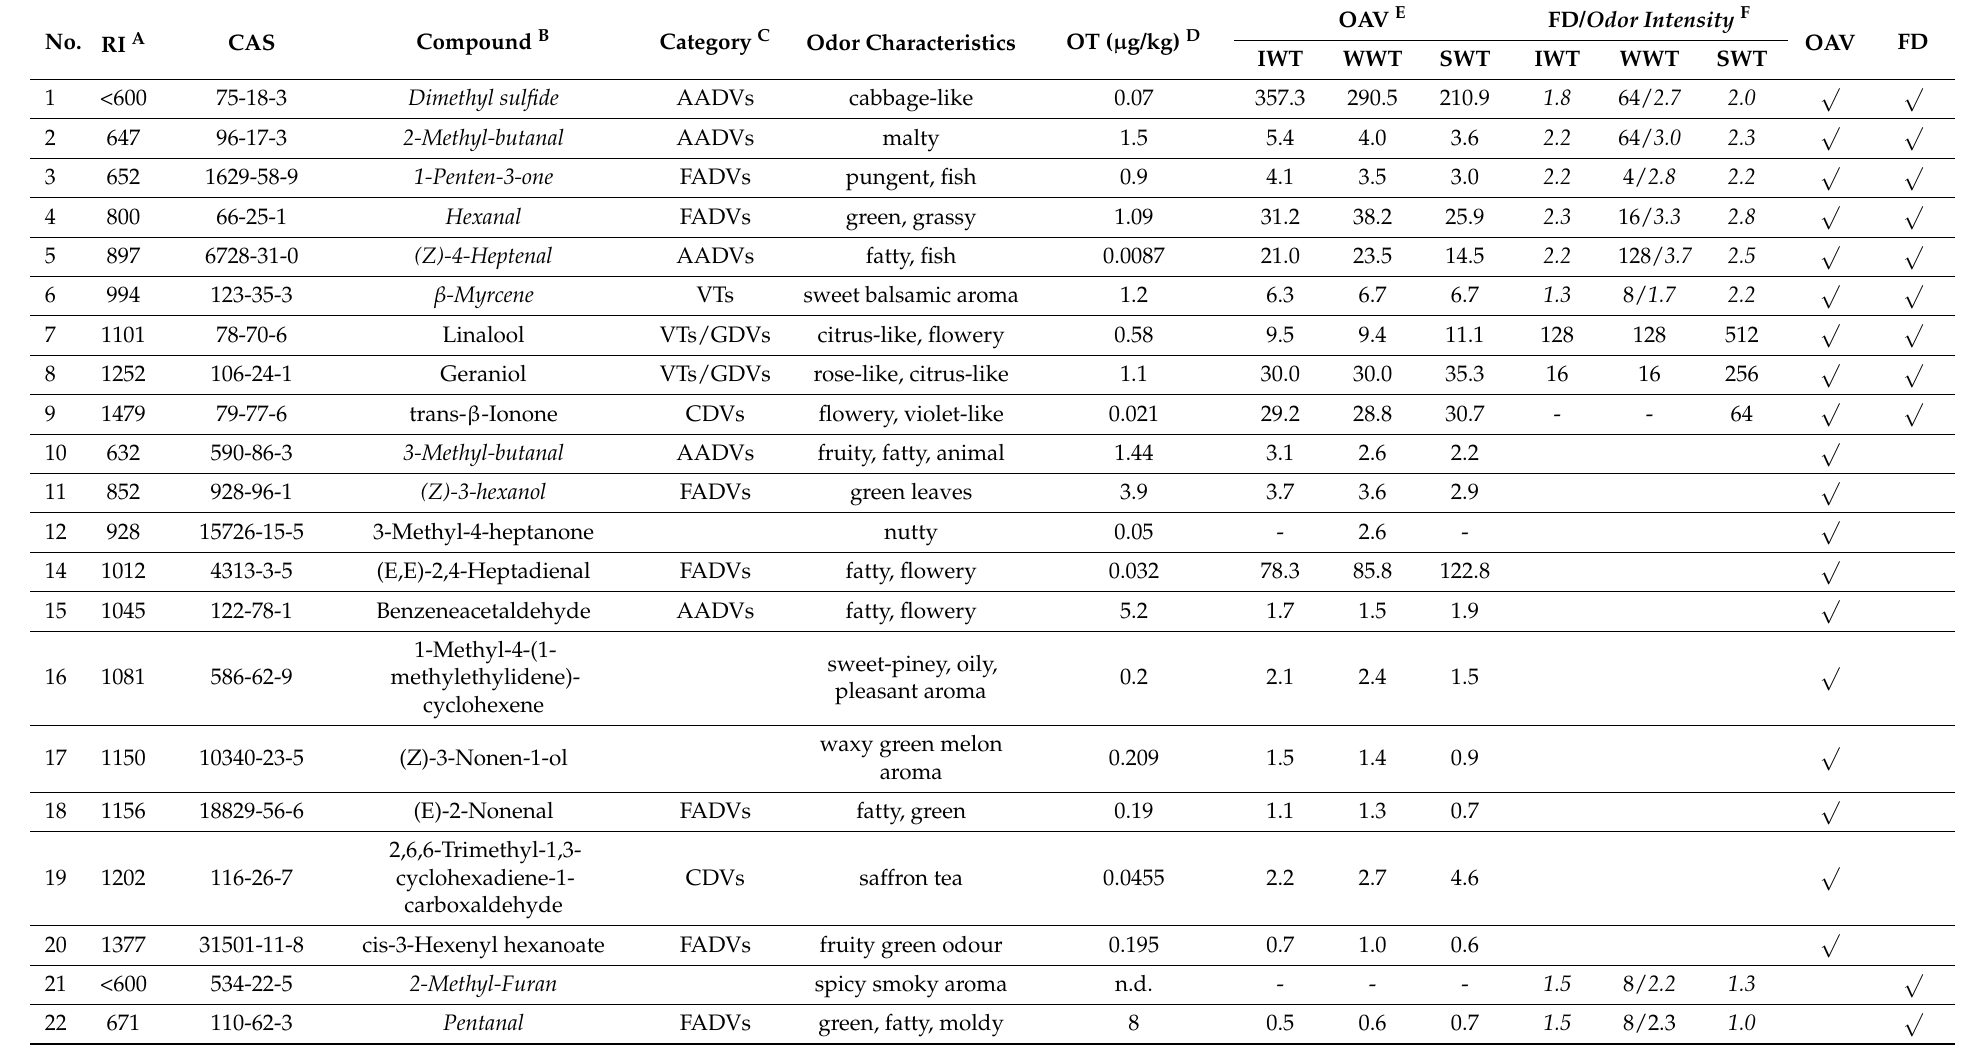
Table 1. Flavor dilution factors and odor activity values for odor-active compounds in three white